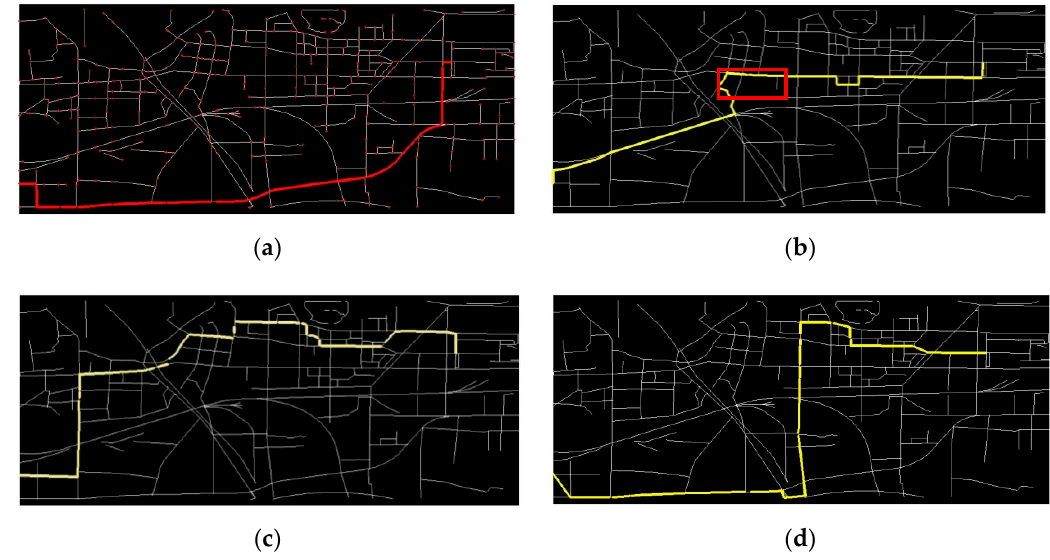
Figure 8. District heating(DH) routes by manual design and the algorithm (cost function value sorted from the smallest to the biggest). ( a ) The manually designed route; ( b ) The route with minimum cost function value; ( c ) The 28 th route; ( d ) The 29 th route.